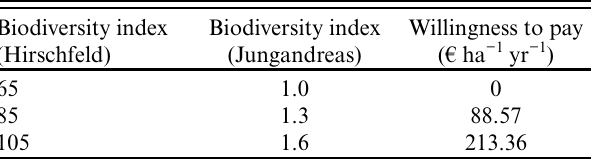
Table 2. Biodiversity indices according to Hirschfeld et al. (2021) related to their respective biodiversity indices according to Jungandreas and willingness to pay.